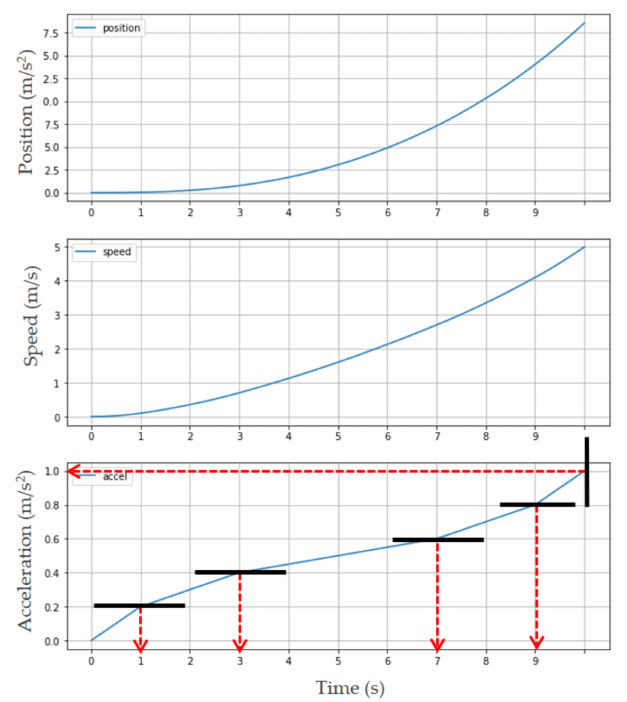
Figure 9. Parameterization example of ∆ T = 10 and M = 5. In this case, the value of y 0 is 1.0 m / s 2 , and the values of y 1 , y 2 are − 0.49 m / s 2 , and y 3 , y 4 are 0.49 m / s 2 . With these values, we determined the key points, shown as red arrows in the